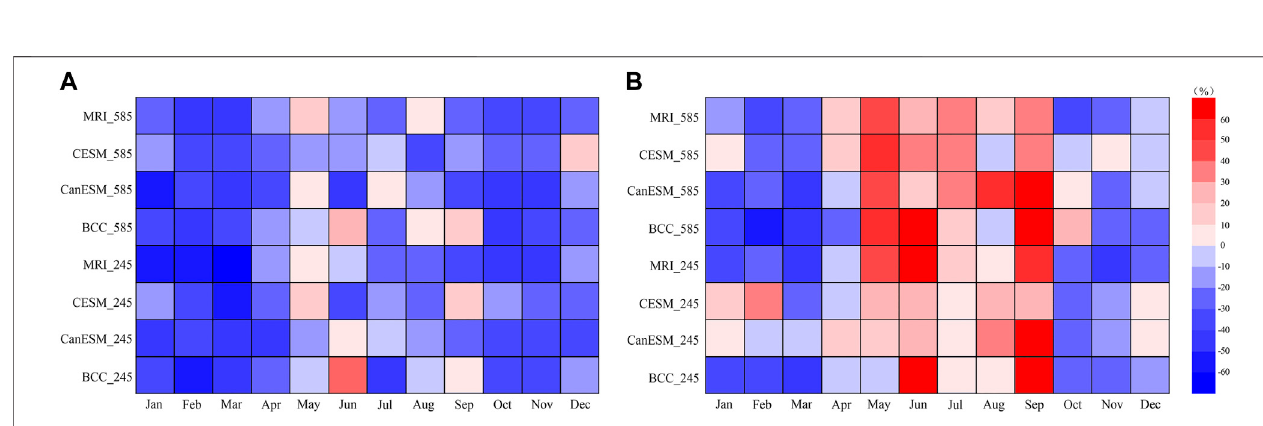
Frontiers in Environmental Science |